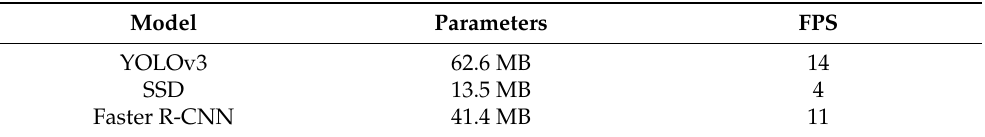
Table 5. Comparison of parameters and detection speed for different learning-based defect detection methods. The size of the test images was 400 ×